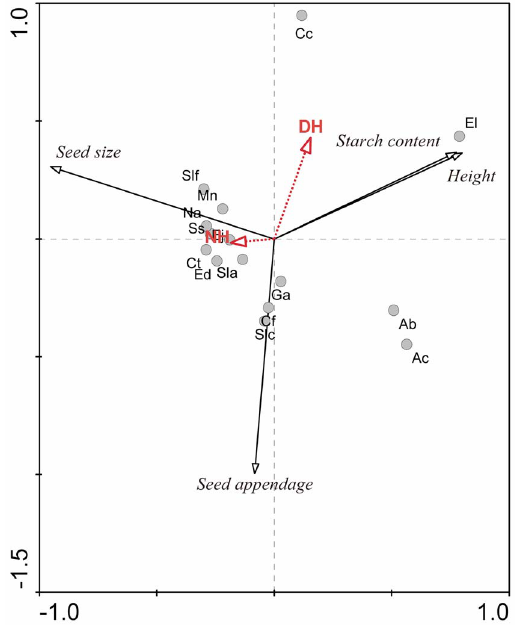
Figure 2. The PCA biplot. Principal component analysis (PCA) based on trunk sprouts in natural sites (NH) and disturbed sites (DH), seed size, seed appendage, starch content in shoot and plant height variables. Circles show sampled species, with abbreviations being as for Table